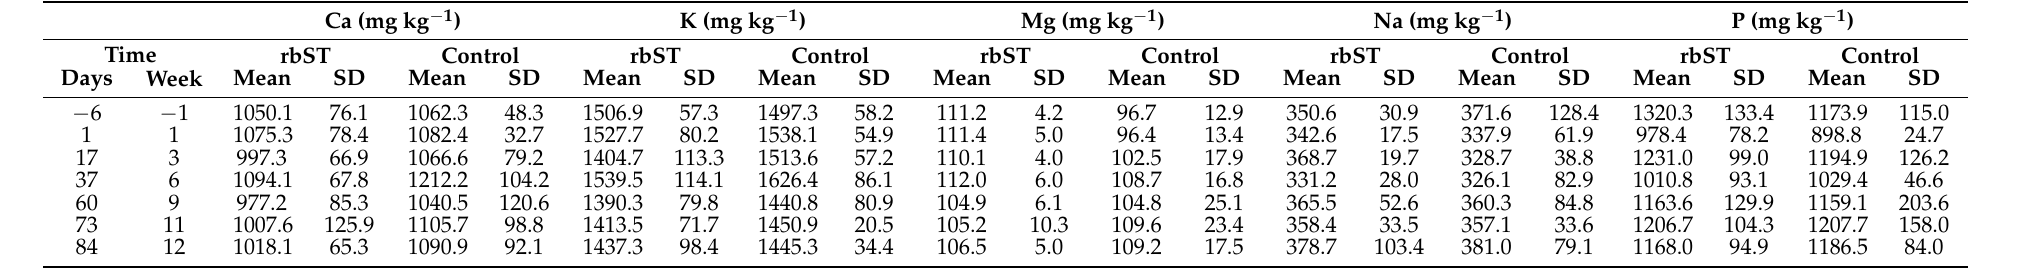
Table 10. Minerals of milk obtained from cows treated with recombinant bovine somatotropin (rbST) ( n = 6) and from control animals ( n = 3) at different time points selected over the course of 37 weeks (8 injections of Lactotropina manufactured by Elanco, Eli Lilly, Mexico).